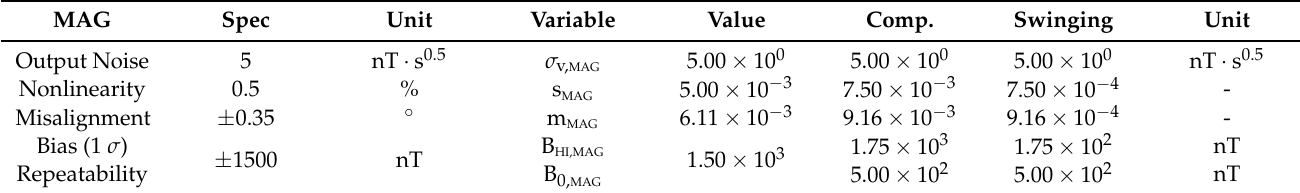
Table 16. Example for magnetometers’ performance